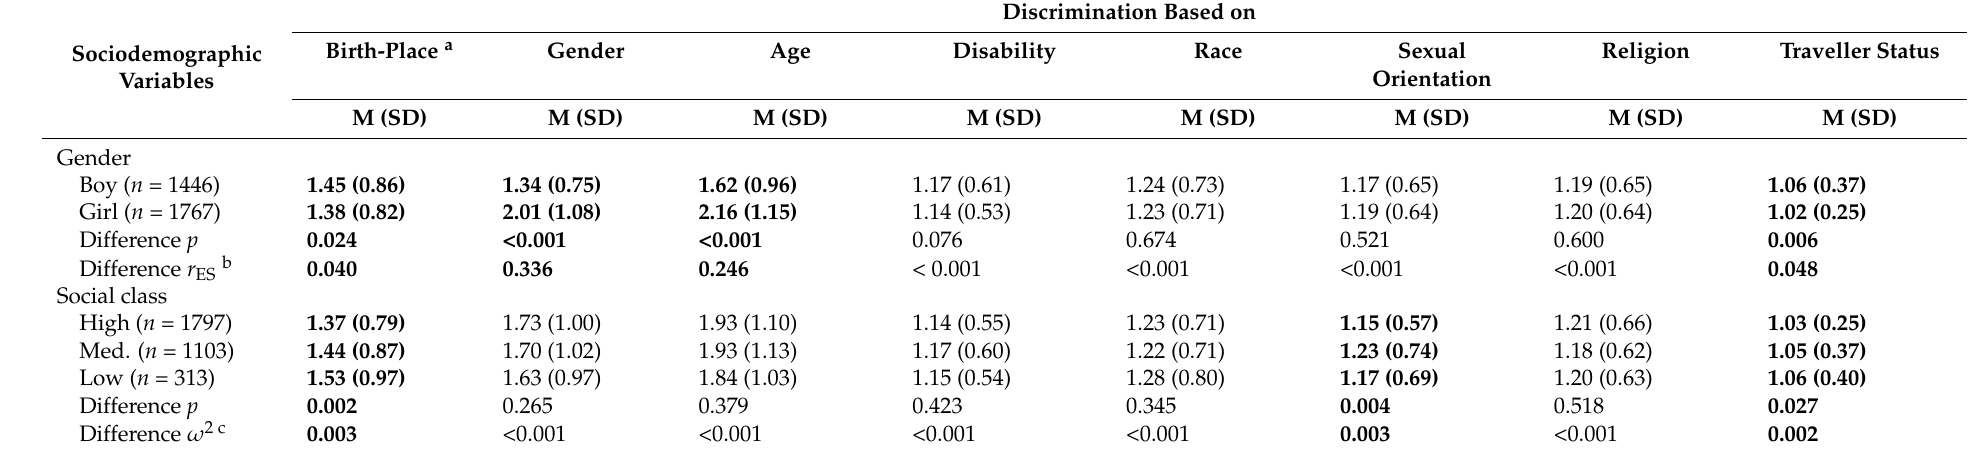
Table 2. Descriptive statistics for discrimination, by gender and social class ( n =